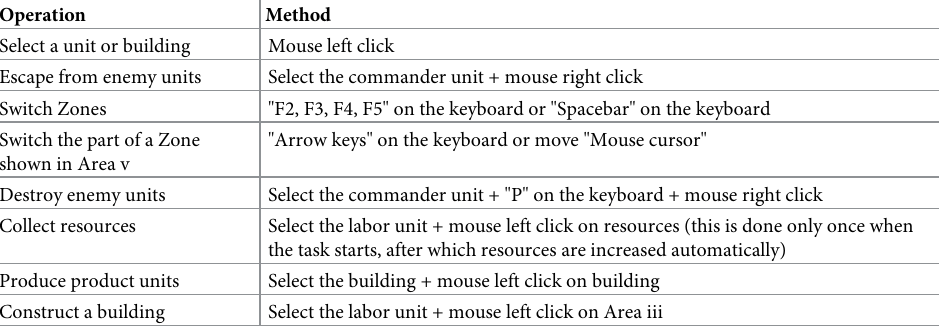
Table 1. Operation method.